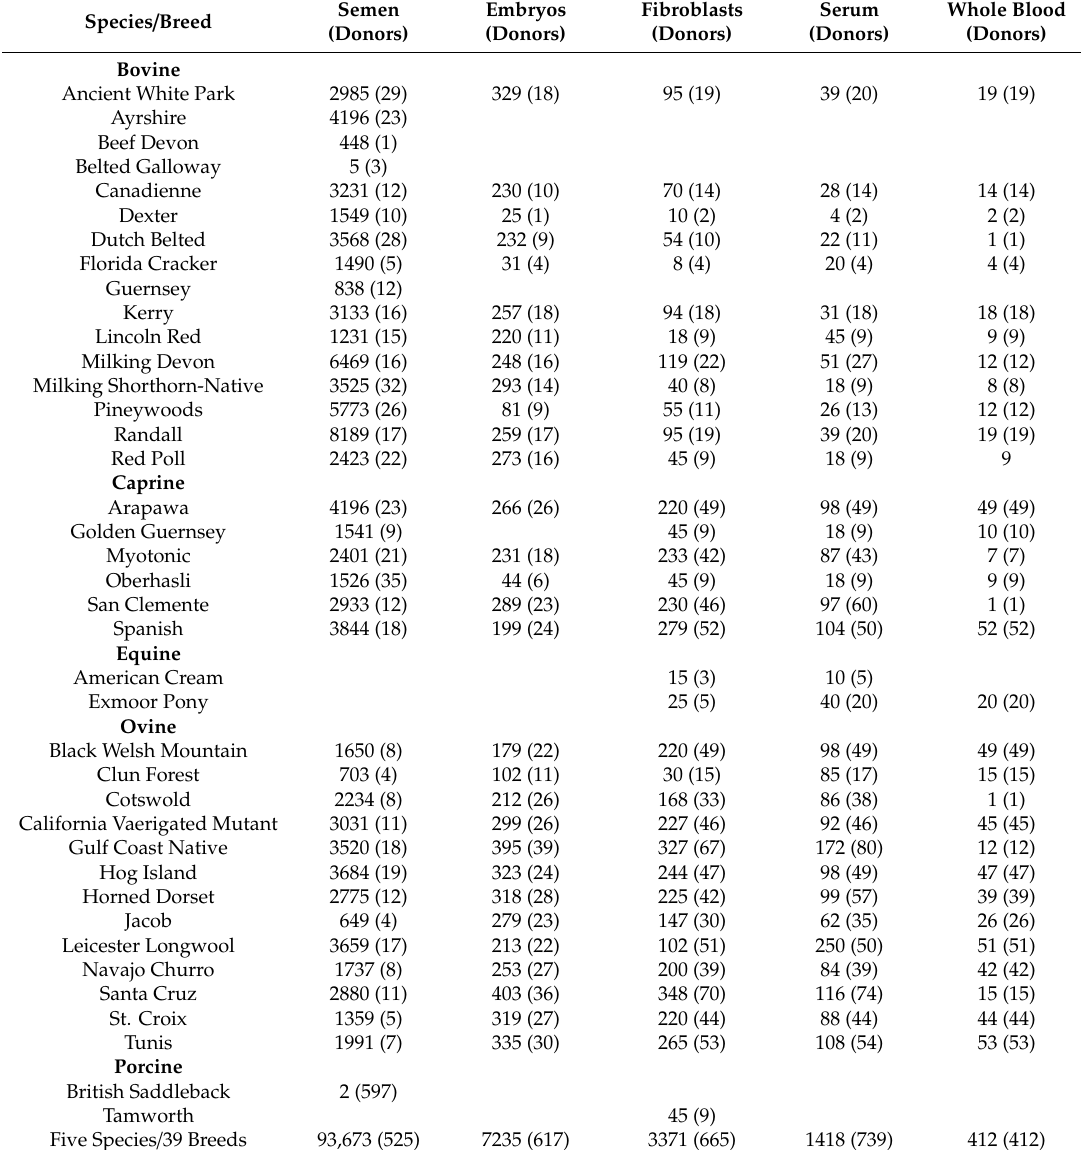
Table 1. SVF Foundation Germplasm Repository